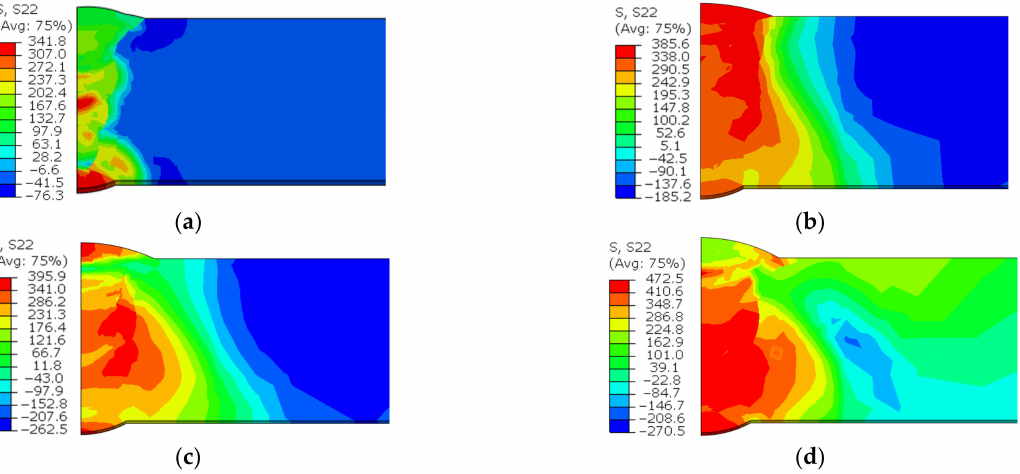
Figure 12. Circumferential stress nephogram with butt gaps of: ( a ) 0 mm, ( b ) 1 mm, ( c ) 2 mm, ( d ) 3 mm.